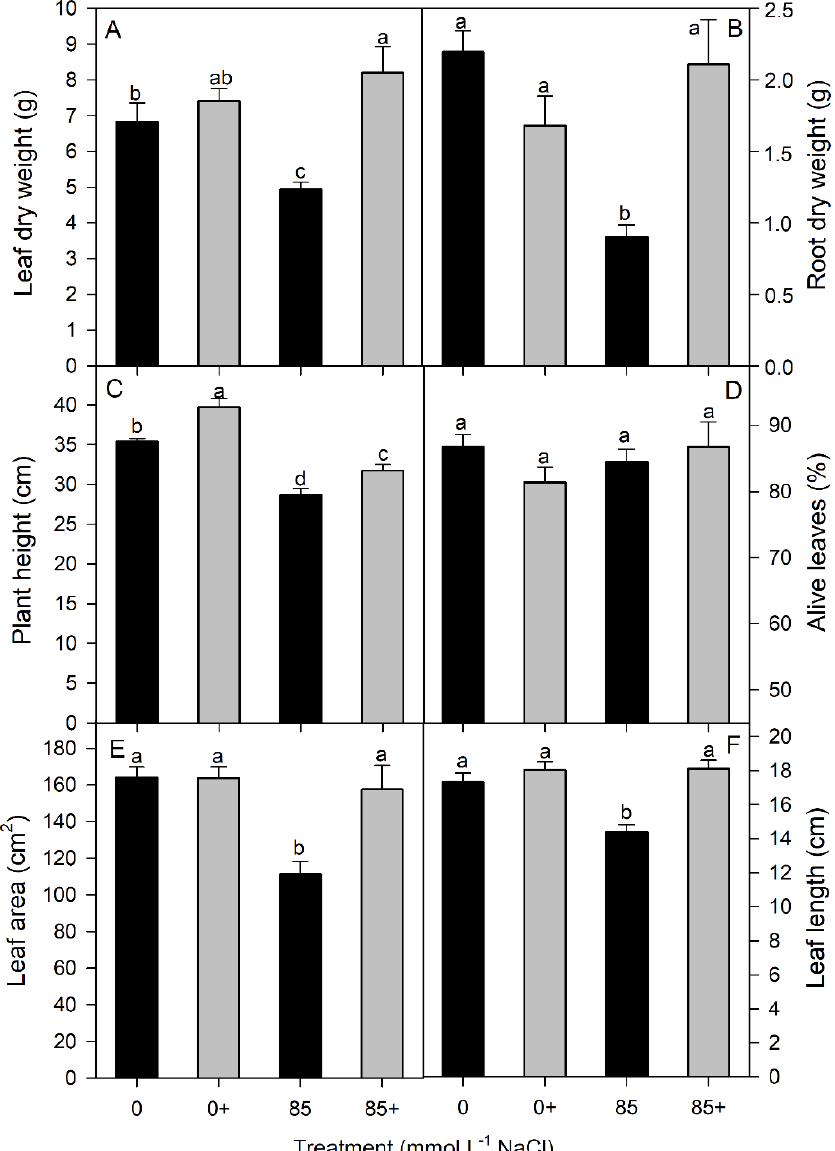
Figure 3. Leaf ( A ) and root ( B ) dry weight, plant height ( C ), percentage of alive leaves ( D ), mean leaf area ( E ) and mean leaf length (F) of Swiss chard after 30 d of treatment with 0 and 85 mmol L − 1 NaCl, non-inoculated and inoculated (+). Each value represents the mean of nine replicates ( n = 18 for leaf area and leaf length) ± SE. Different letters indicate means that are significantly different from each other (ANOVA; Duncan test, p < 0.05).